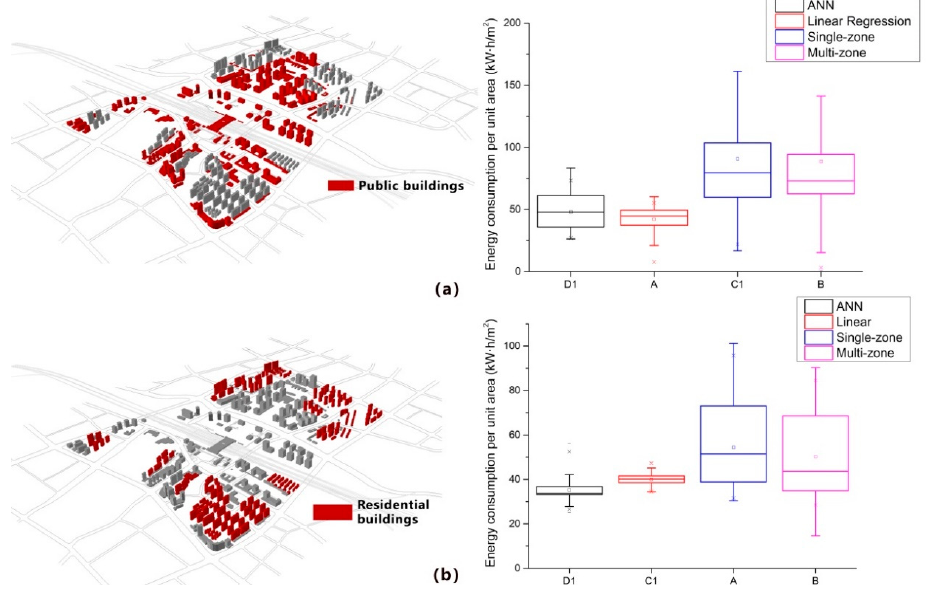
Figure 9. Comparison of energy consumption per unit area of four calculation methods: ( a ) dispersion of energy consumption intensity of public buildings; ( b ) dispersion of energy consumption intensity of residential buildings.